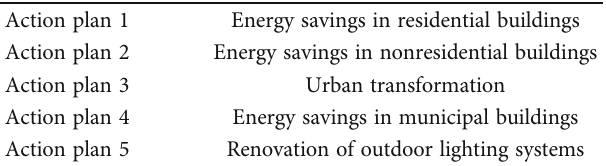
Figure 3: Sectoral shares of building based greenhouse gas emissions. Table 3: Buildings sector action plans for Sakarya